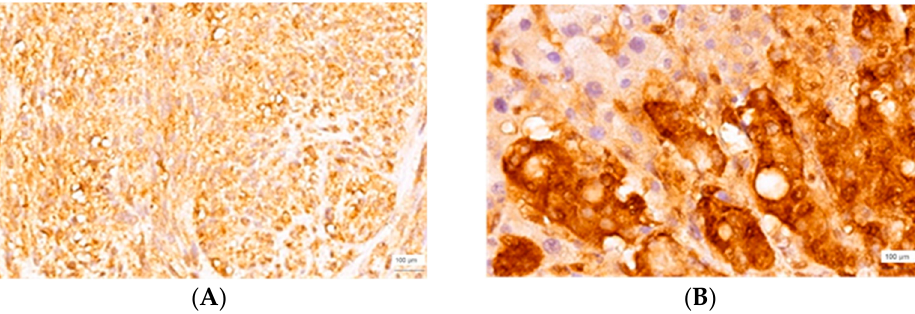
Figure 5. CLIC1 immunoexpression, pancreatic adenocarcinoma, score of 3, ×200 magnification ( A ) and corresponding LM, replacement HGP, score of 3, ×400 magnification ( B ).